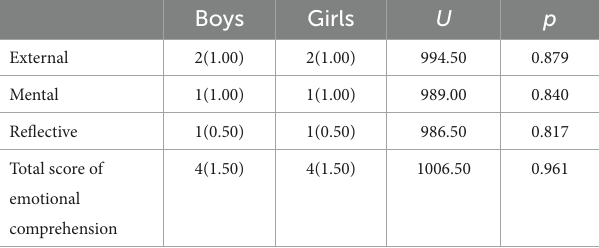
TABLE 5 Results of gender difference on children’s emotional comprehension.